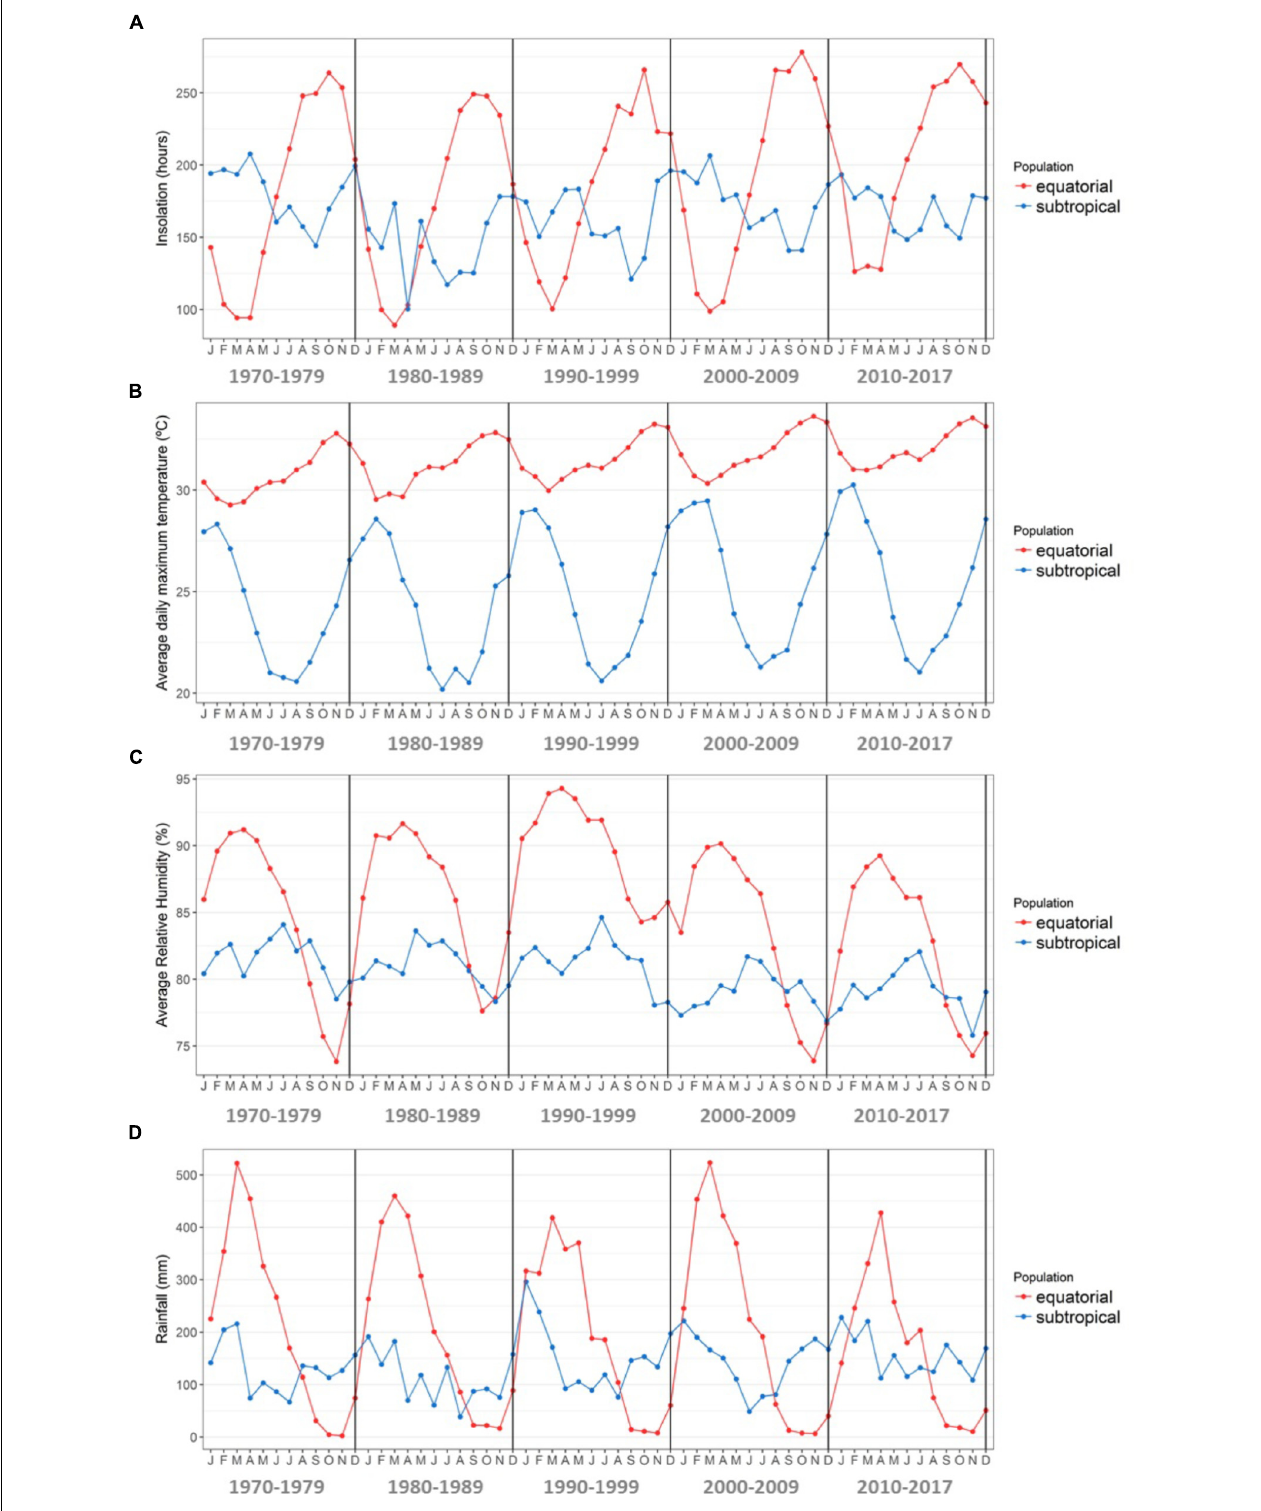
FIGURE 9 | Climate characterization during the period 1970–2017 in the equatorial and subtropical sampling sites. Data were downloaded from the Tracuateua (1.06 ◦ S/46.90 ◦ W) and Florianópolis (27.58 ◦ S/48.56 ◦ W) automatic weather stations of the Brazilian National Institute of Meteorology (INMET) website. (A) Average monthly insolation in each decade (hours). (B) Average daily maximum temperature per month in each decade ( ◦ C). (C) Average monthly atmospheric relative humidity in each decade (%). (D) Average monthly rainfall in each decade (mm).